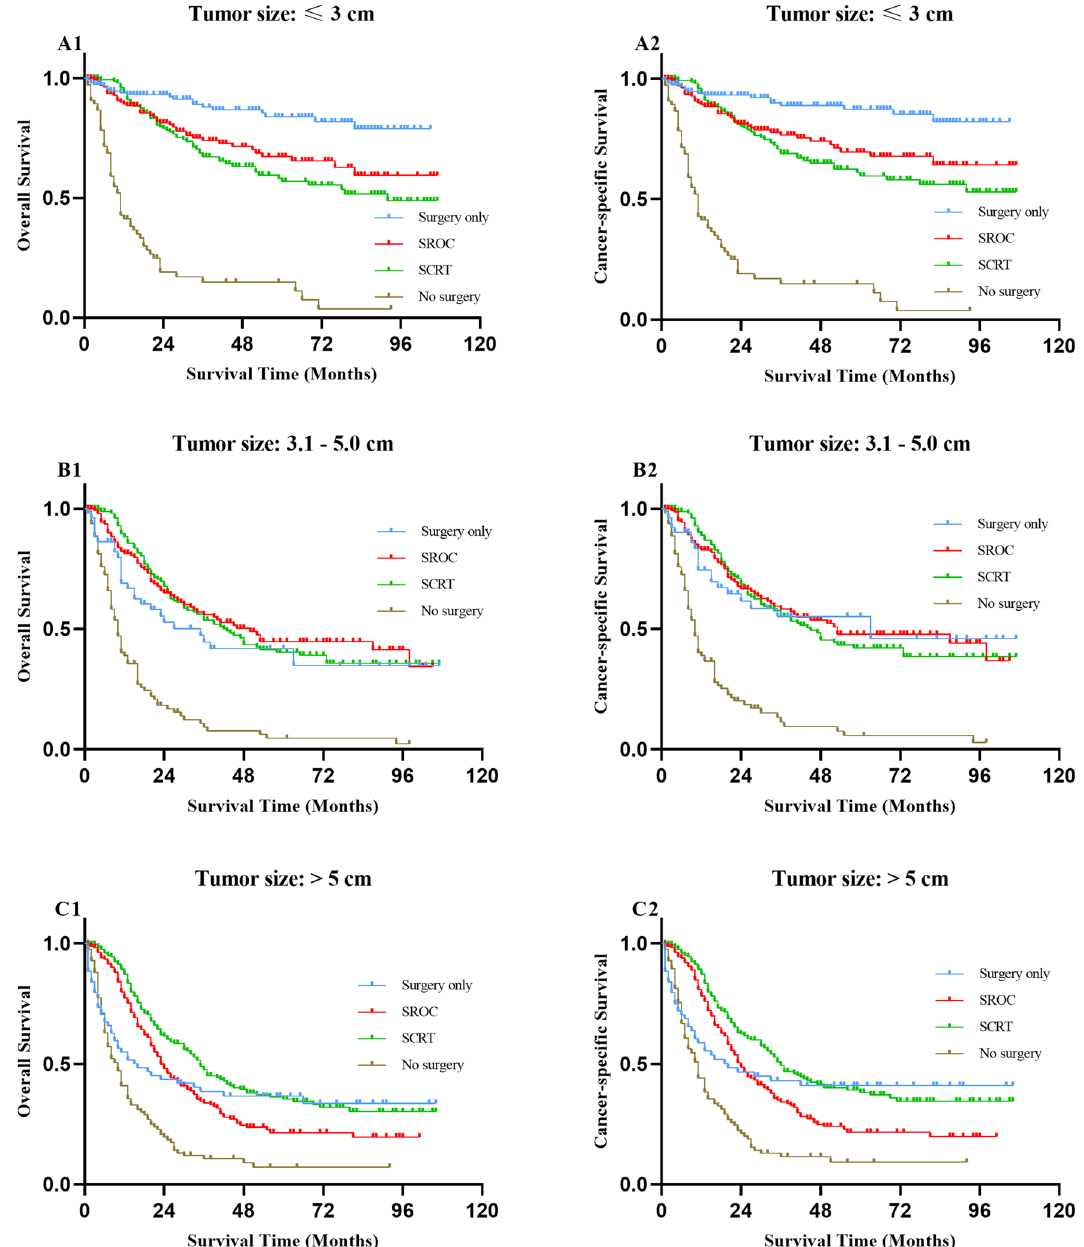
Figure 5. Kaplan–Meier survival curves for ( A1 , B1 , C1 ) overall survival and ( A2 , B2 , C2 ) cancer-specific survival in patients with tumor size ≤ 3 cm, 3.1–5 cm, > 5 cm undergoing different treatments respectively. SROC, surgery plus radiotherapy or chemotherapy; SCRT, surgery plus